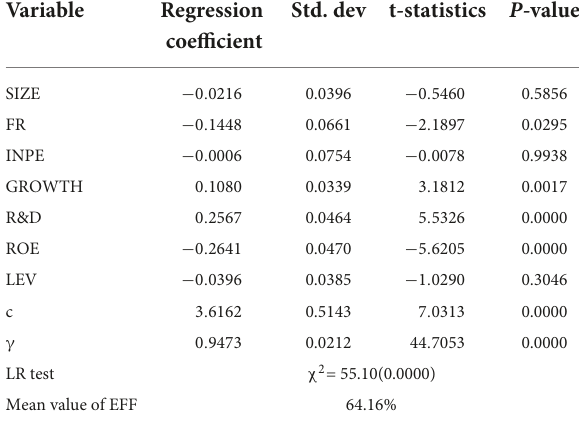
TABLE 3 Regression results of the IPO pricing efficiency model on the STAR market.